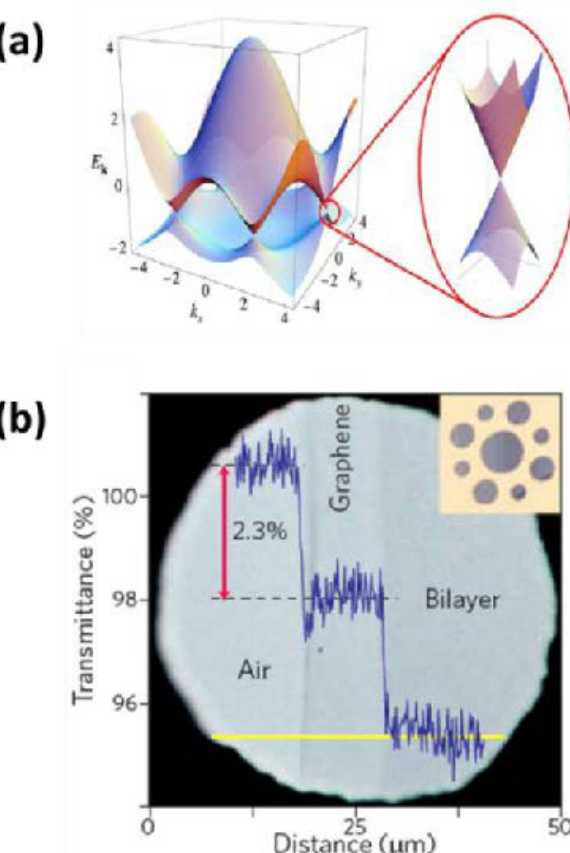
Figure 7: (a) Electronic dispersion of a single layer graphene. (b) Optical transmittance for an increasing number of layers. Inset is the experimental design of Ref. [153], showing a thick metal sup- port with several apertures, on top of which graphene flakes are placed. Figures with reprint permission from: (a) Ref. [15] ©2009 The American Physical Society, and (b) Ref. [153] ©2008 AAAS.